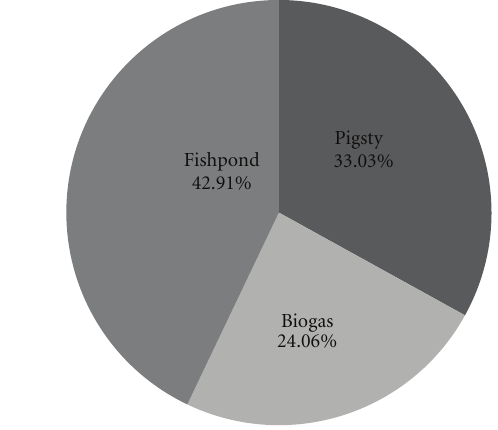
Figure 4: GM fractions for the “pig-biogas-fish” system.